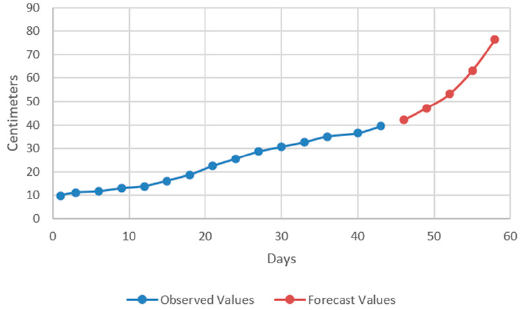
Figure 11. The evolution of basil shoot height in BH experimental variant.